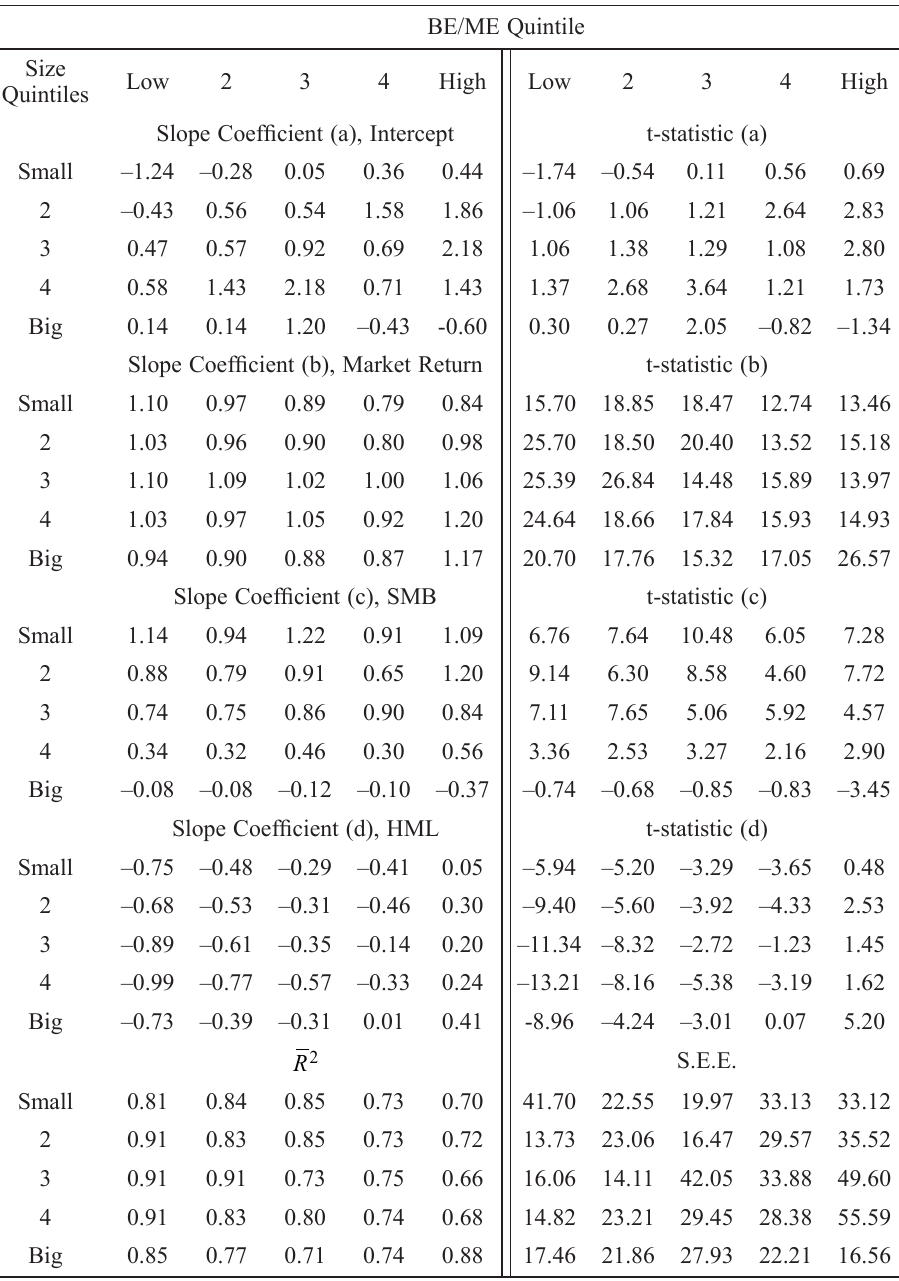
Table 6. Three-factor model: regression of excess stock returns on the excess stock-market return, SMB, and HML (Jan. 1996 to Dec. 2009, N = 144) Panel